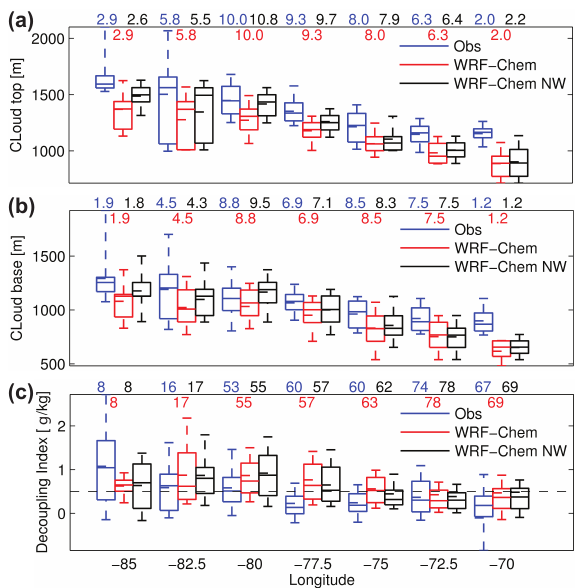
Fig. 3. Box and whisker plots for different variables derived from aircrafts measurements as in Fig. 1. (a) and (b) : cloud top and bot- tom from U. of Wyoming radar (WCR) and lidar (WCL), respec- tively. (c) Decoupling index, the horizontal dashed line indicates the 0.5gkg − 1 decoupling threshold (see explanation on the text). The numbers above each zone represent sampling time in decimal hours for (a) and (b) , and number of profiles for (c)